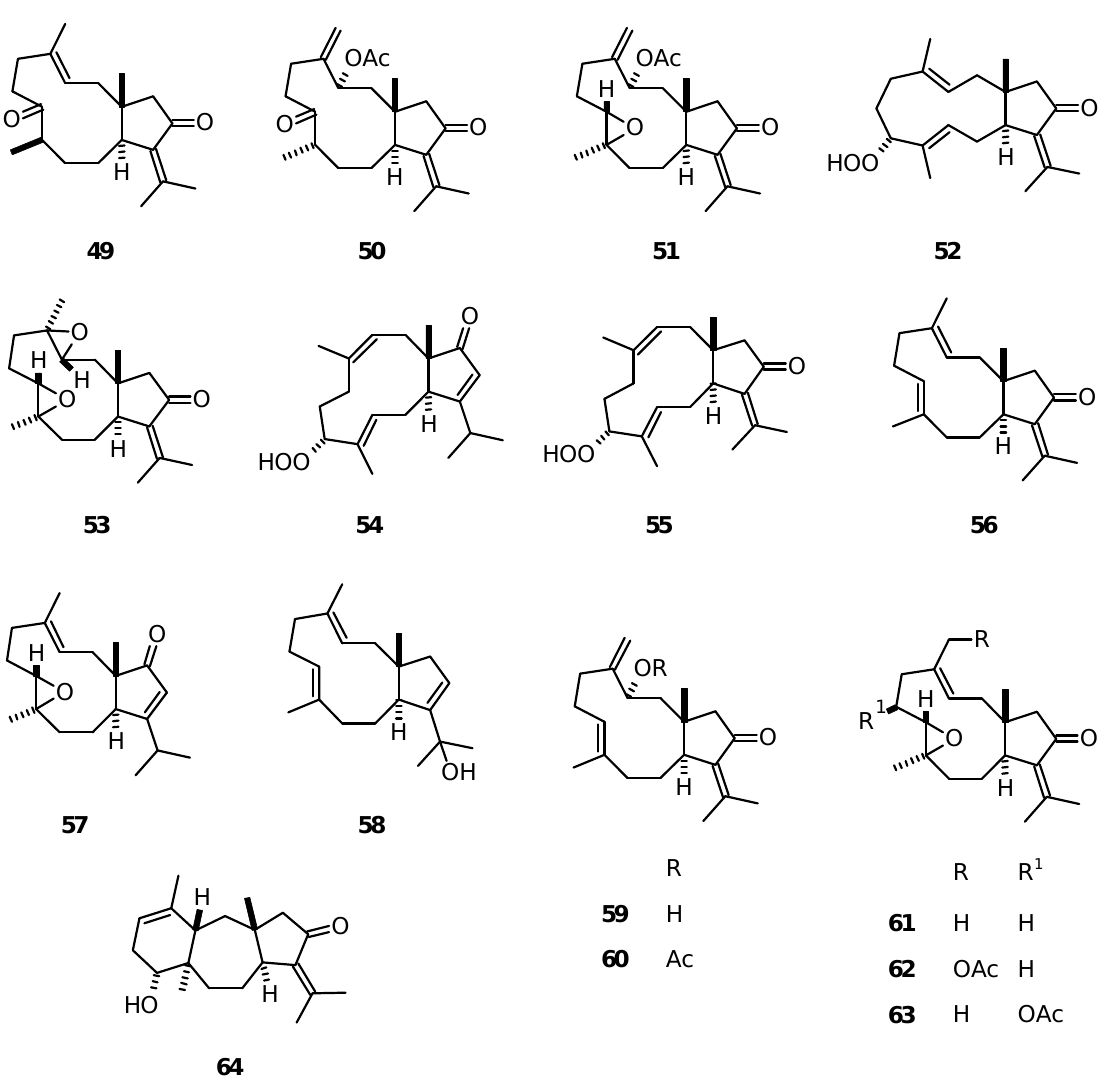
Figure 5. Structures of dolabellanes 49 - 63